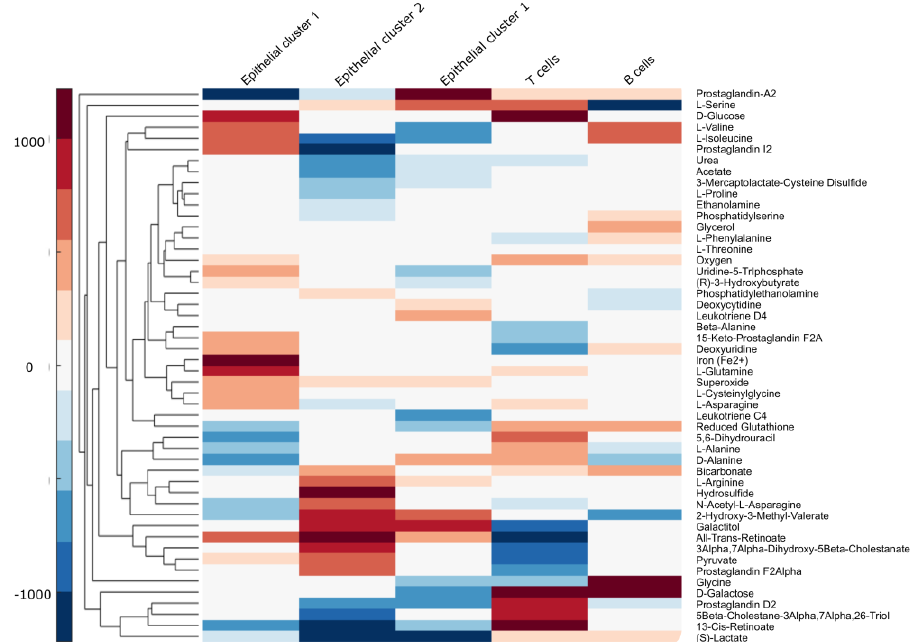
Figure 4. Metabolic exchanges: A Flux Variability Analysis was run while optimizing for the biomass reactions of the 5 clusters. The optimization coefficients were weighted according to the population size. For each biomass function, a minimal flux of 10% of the flux obtained when the biomass is unique optimization function was imposed. The cluster gram depicts the exchange between the cytoplasm of the sub-models and the microenvironments. As metabolites can participate in several transport reactions, the average fluxes were summed up. The exports and imports are depicted in red and blue, respectively.